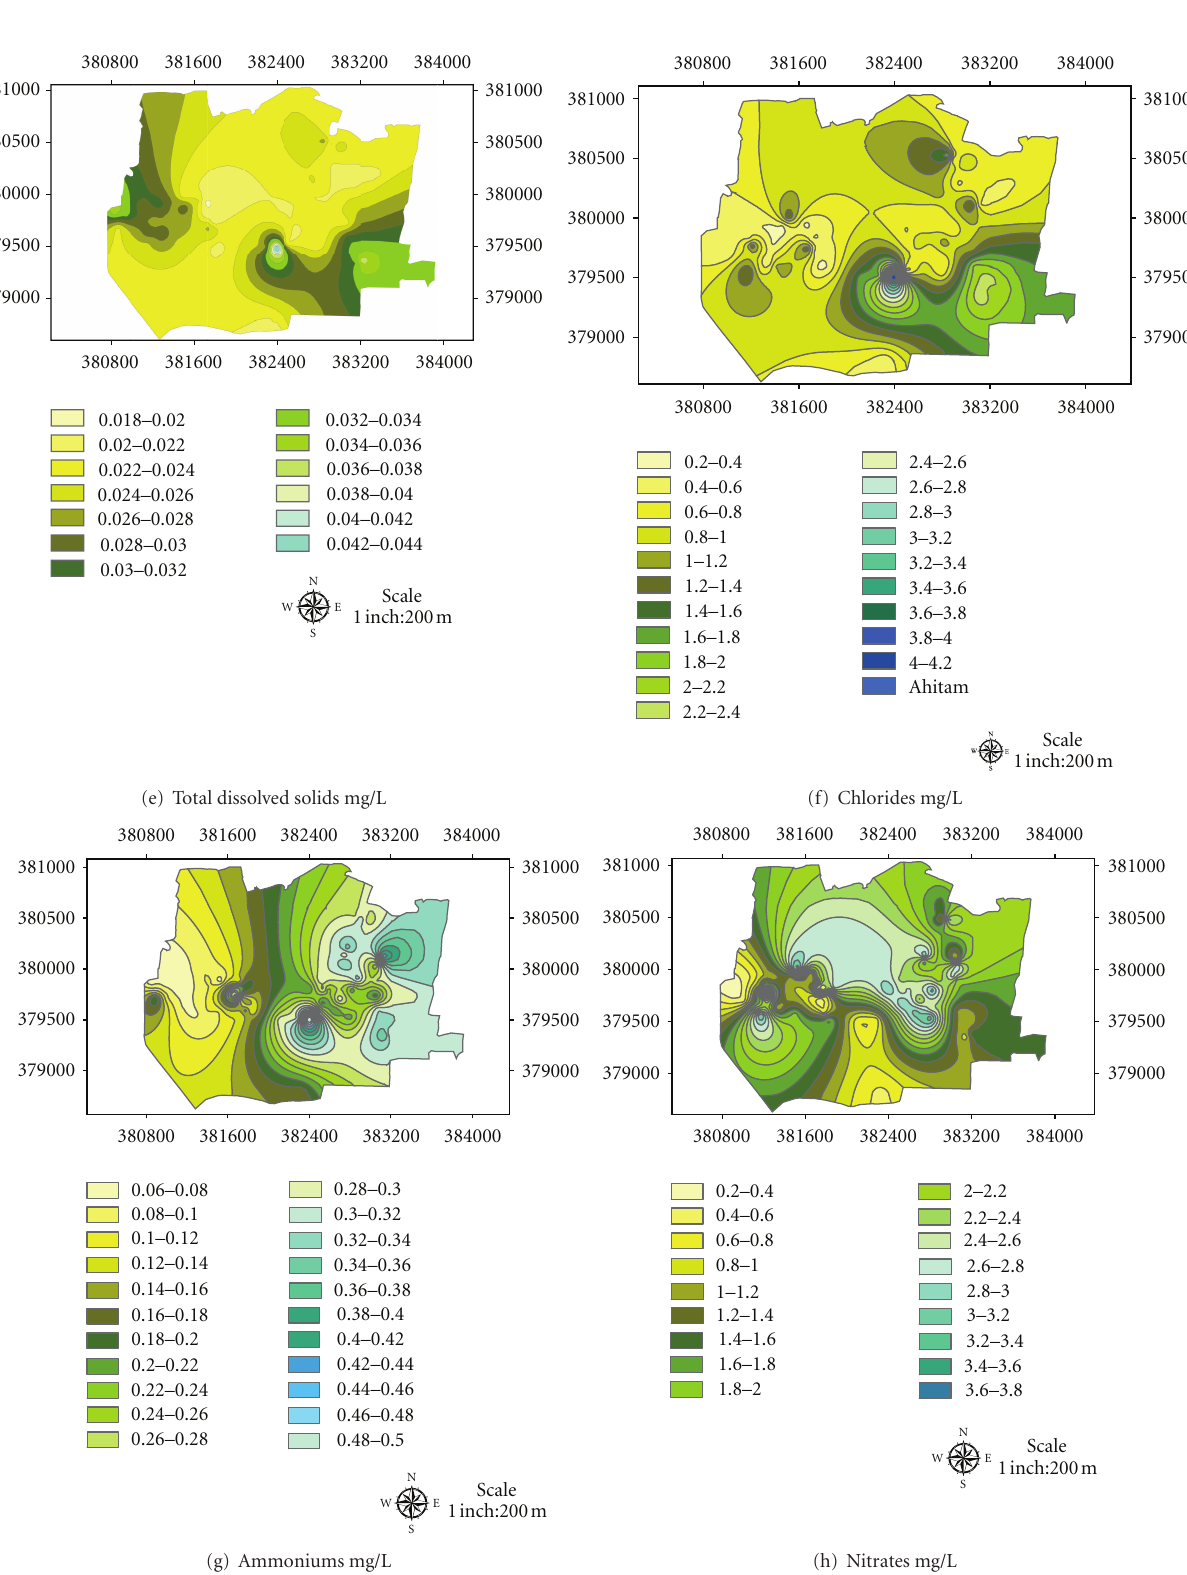
Figure 14: Water quality characterization of the